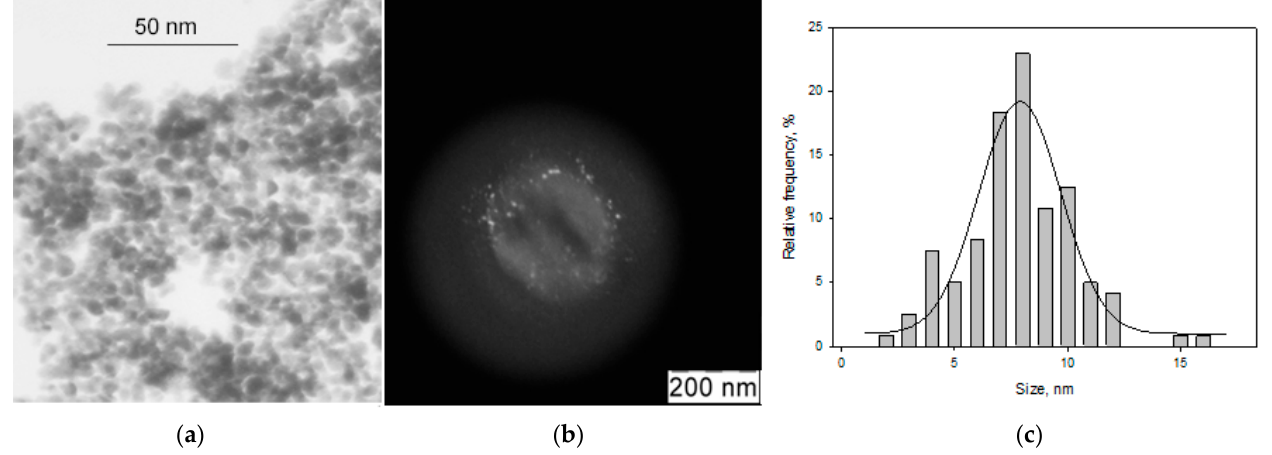
Figure 2. TEM images in a light ( a ) and dark ( b ) field, and the size distribution ( c ) of Au nanoparticles in the Au-acetone system.